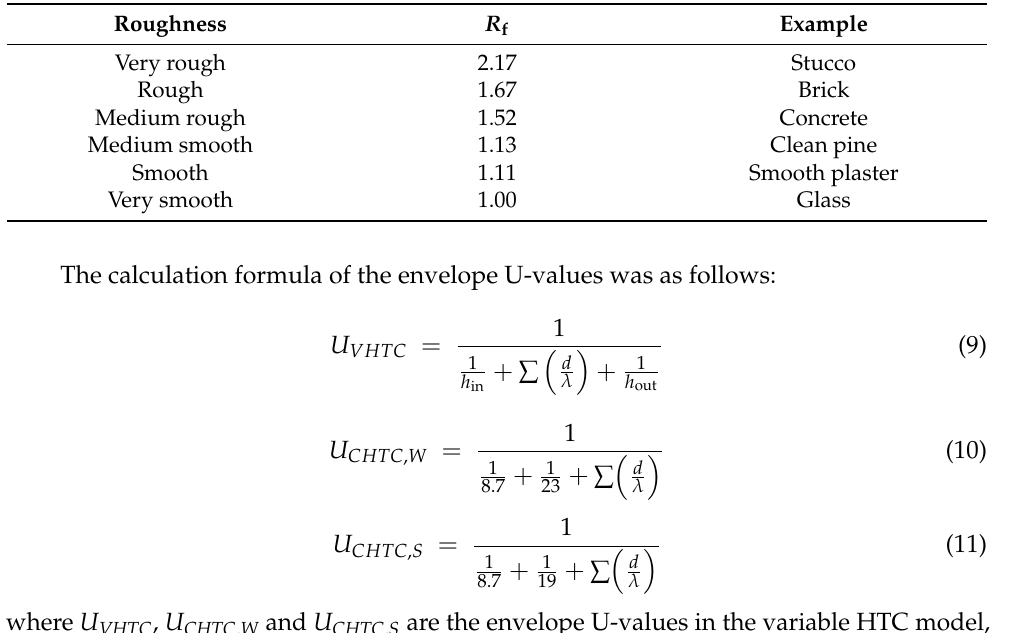
Table 3. Surface roughness